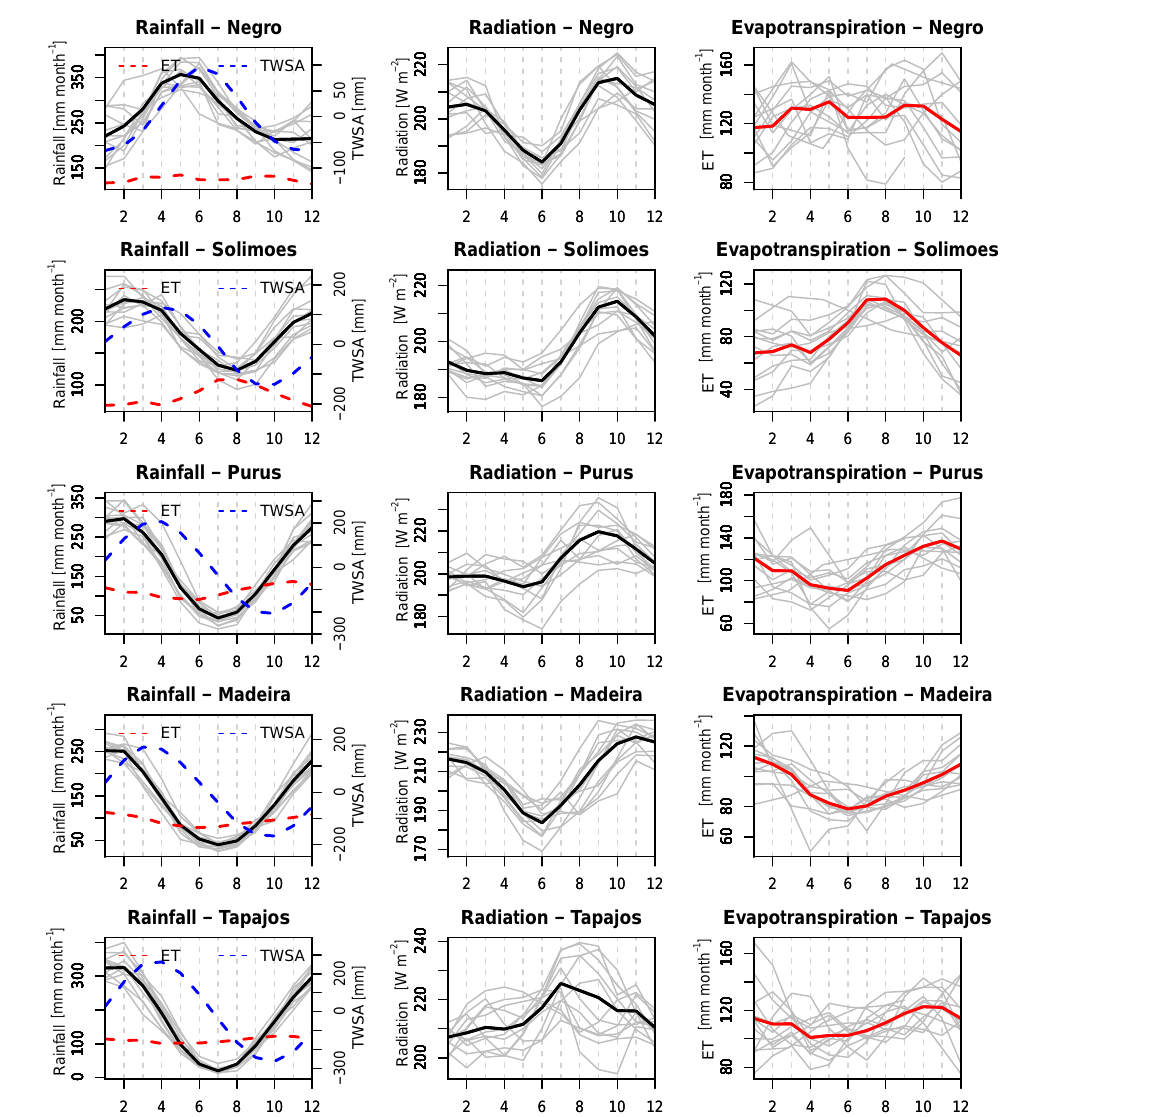
Figure 3. Seasonal variations in rainfall, radiation, and evapotranspiration inside each sub-basin. Grey lines represent the values for each year from 2002–2014, and solid dark lines represent the average values for each month. Months are represented from 1 (January) to 12 (December). The dashed blue line in the first column shows the mean seasonal variation in GRACE terrestrial water storage anomalies (TWSA), and the dashed red line is the mean seasonal variation in water balance ET, for each sub-basin. Vertical bars indicate the uncertainty in the water budget